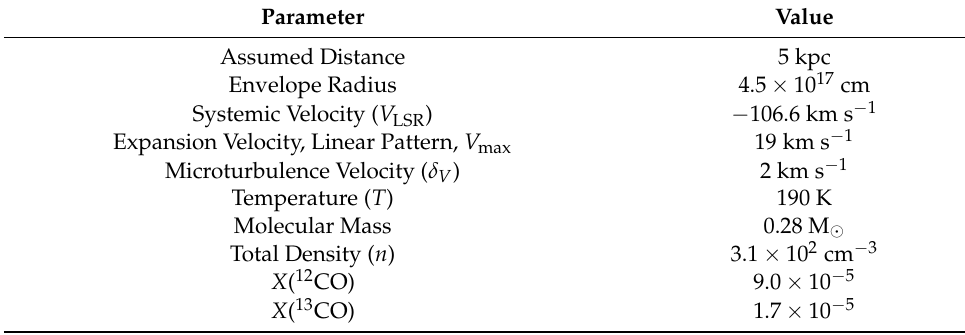
Table 2. Best-fit model physical parameters for the molecular emission of IRAS 17393 −